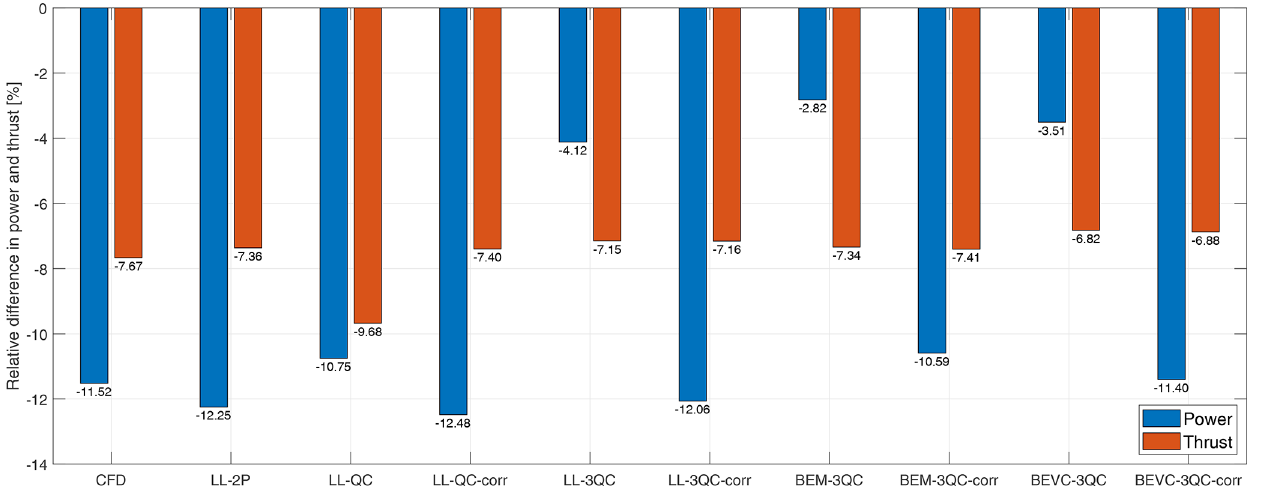
Figure 20. The relative difference in thrust and power of the rotor with straight blade with 15 ◦ of downwind coning compared to the zero-cone-angle